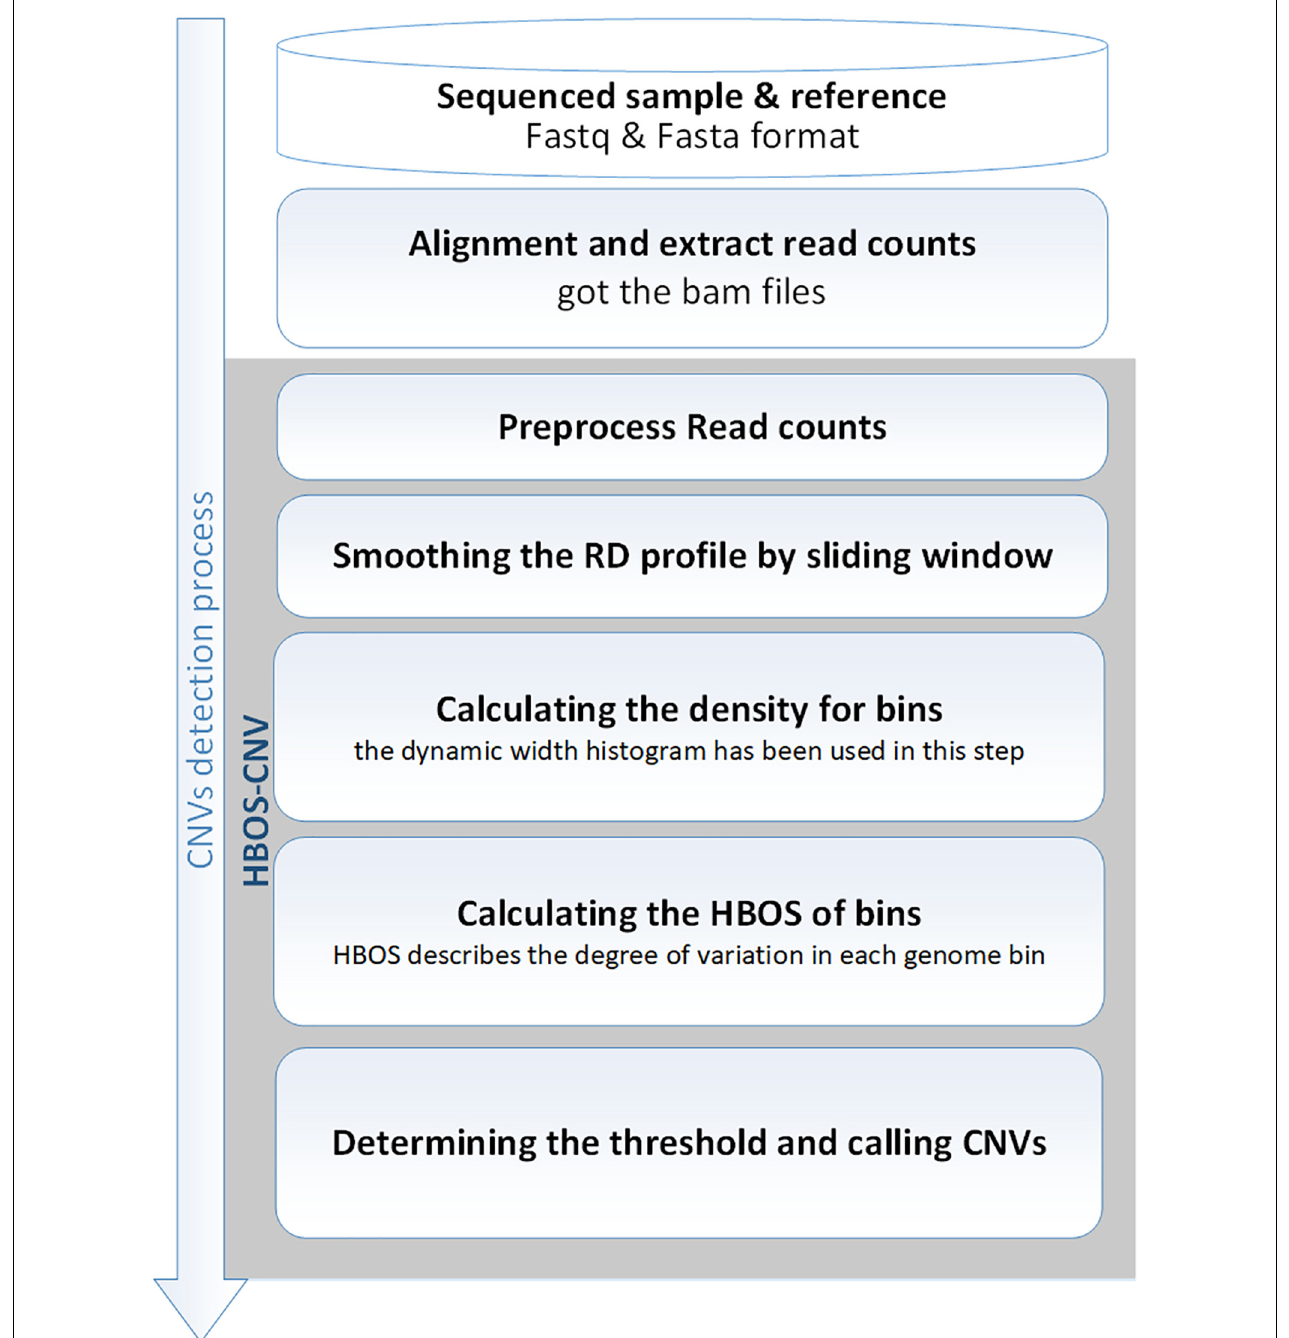
FIGURE 1 | Diagram showing the HBOS-CNV workflow. It includes the main steps for processing input read count profiles from SAMtools: preprocessing, smoothing, calculating the density of bins, calculating the HBOS, determining the threshold, and calling the CNV.